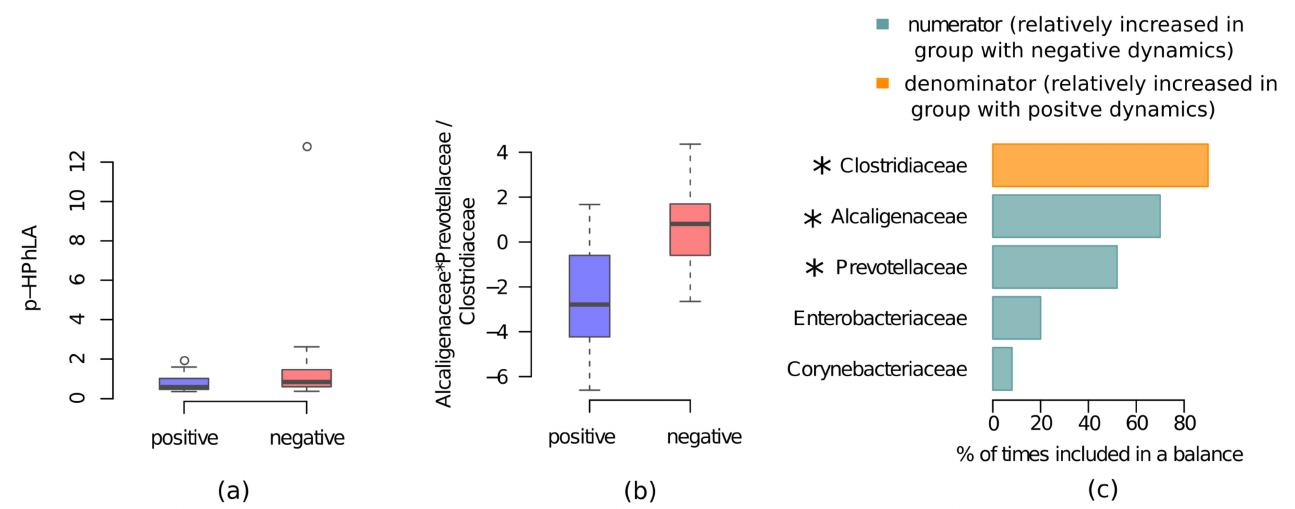
Figure 2. Associations between metabolic and microbiome profiles and positive and negative dynamics in the CCI patients. ( a ) The p-HPhLA levels in patients with positive and negative dynamics, the circle denotes boxplot outliers. ( b ) Values of microbiome balance at the level of families which was selected as the optimal one to distinguish the patients with positive and negative dynamics. ( c ) Reproducibility barplot for the 3 most frequent balance members during the cross-validation procedure (blue bars correspond to numerator members (part of balance more abundant in patients with negative dynamics) and orange-to the denominator members (part of balance more abundant in patients with positive dynamics)). Asterisks (*) denote taxa which are considered to be reliably associated with the group according to the balances-based approach (reproducibility of bacterial taxa > 50% and R 2 >